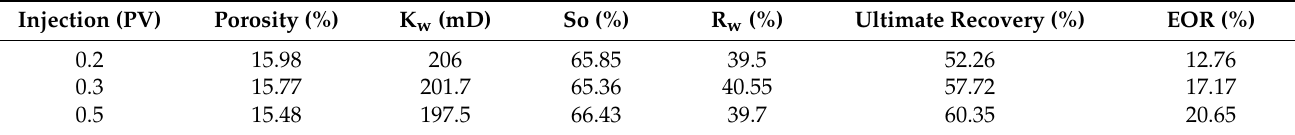
Table 7. Summary of oil displacement experiment